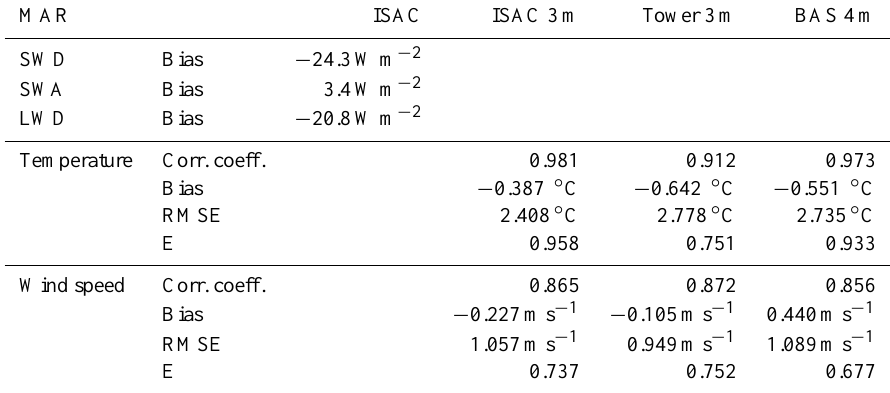
Table 1. Correlation coefficient, bias, RMSE (root mean square error) and efficiency statistical test of the simulated short-wave downward radiation (SWD), the short-wave absorbed radiation by the surface (SWA), the long-wave downward radiation (LWD), the temperature and the wind speed when compared to the observations made by ISAC (Istituto di Scienze dell’ Atmosfera e del Clima) (third and fourth column), by LGGE (Laboratoire de Glaciologie et de Géophysique de l’Environnement) (at the tower, fifth column) and by BAS (British Antarctic Survey) (sixth column). Data were averaged over an interval of 30min. MAR ISAC ISAC 3m Tower 3m BAS 4m SWD SWA Bias Bias Corr.